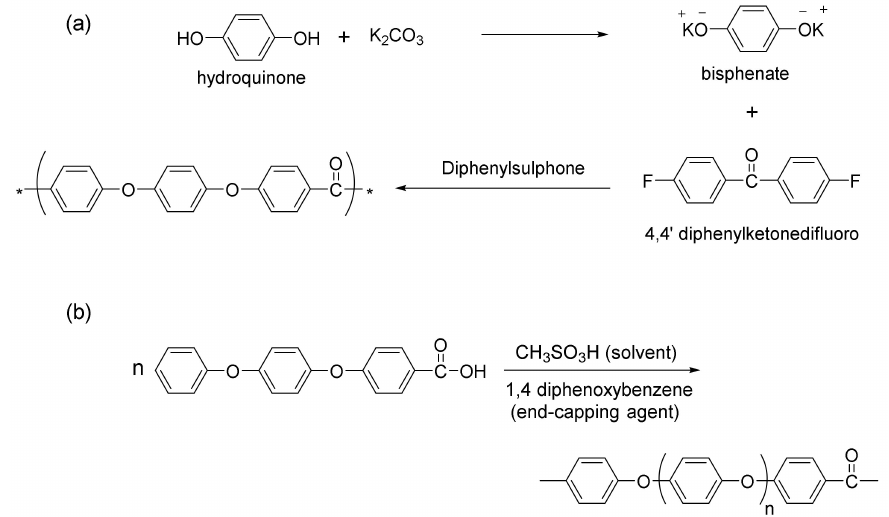
Figure 8. ( a ) Nucleophilic and ( b ) electrophilic PEEK synthesis. Adapted with permission from [53]. Copyright 2019,